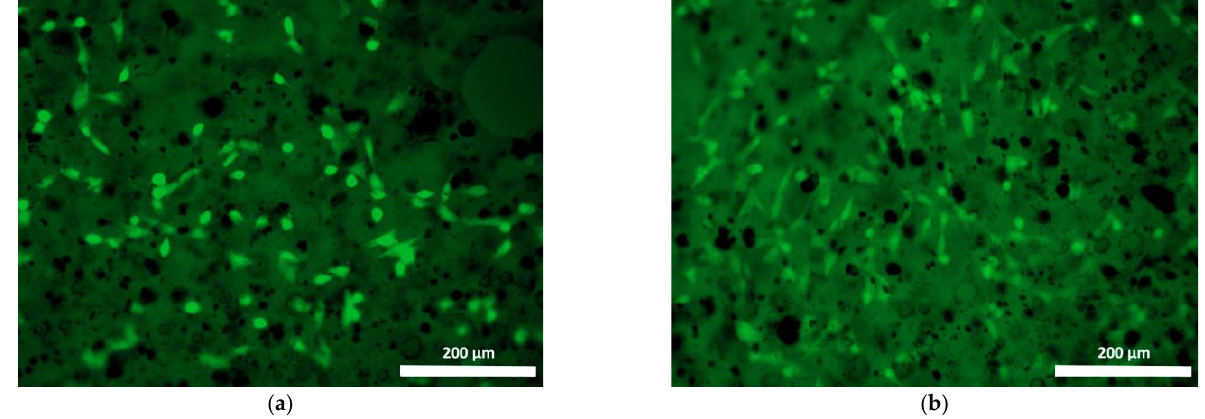
Figure 10. Viable fibroblasts on the surface of Composition 3 specimen (fluorescence microscopy, fluorochrome — Calcein AM, BD Pharmingen ™ ): ( a ) 24 h cultivation; ( b ) 72 h cultivation. mag.100×. fluorochrome—Calcein AM, BD Pharmingen™): ( a ) 24 h cultivation; ( b ) 72 h cultivation. mag. 100 ×